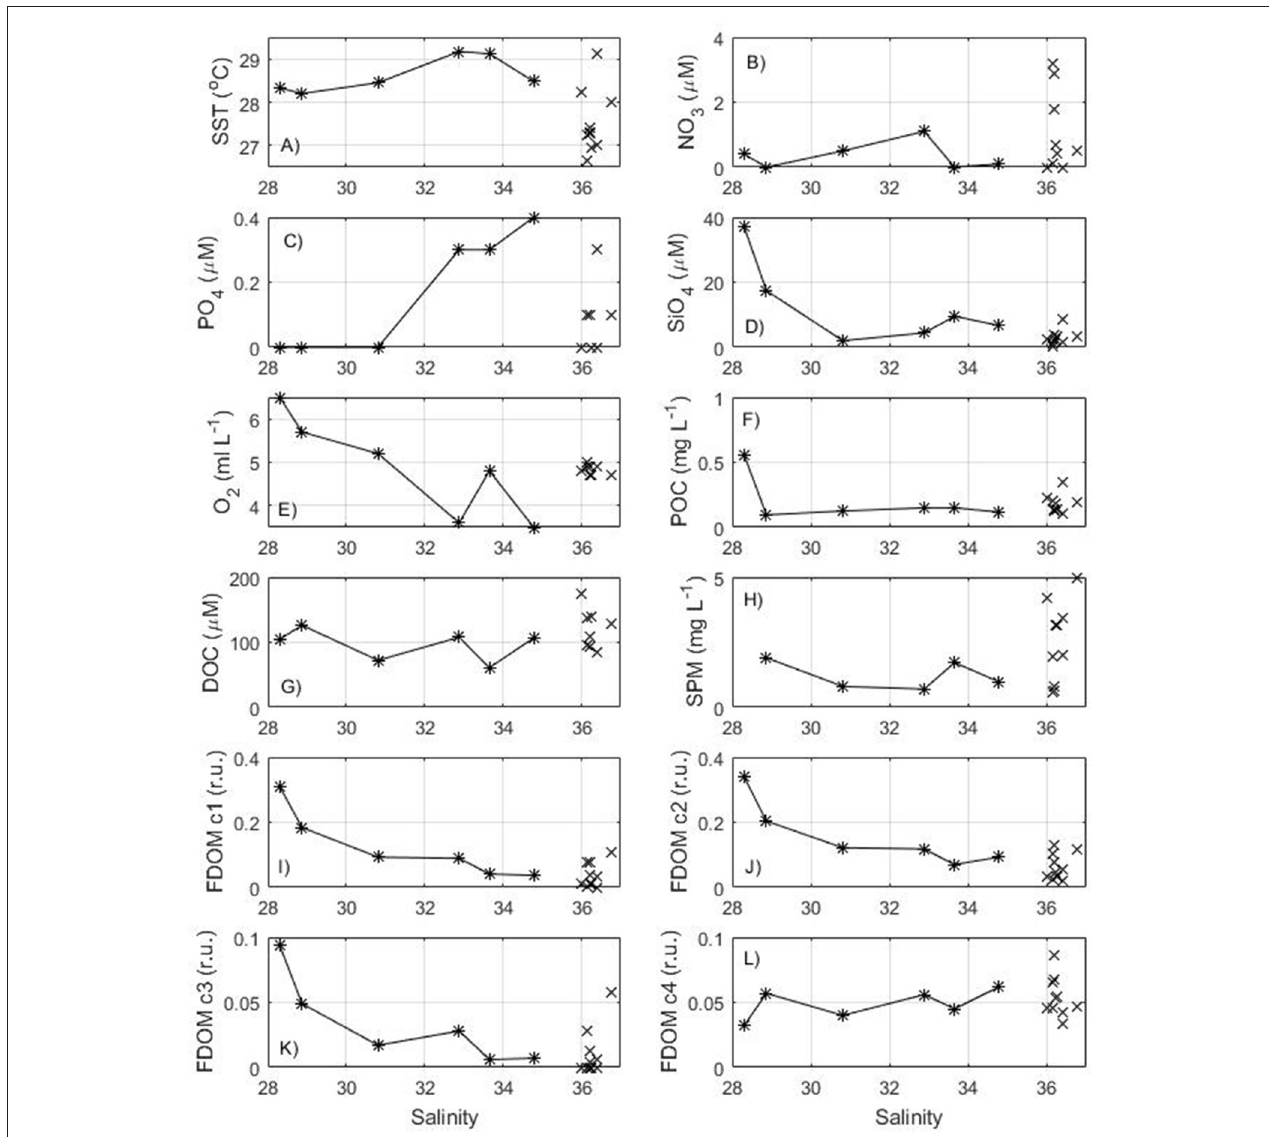
FIGURE 4 | Distribution of surface (A) temperature, (B) nitrate, (C) phosphate, (D) silicate, (E) dissolved oxygen, (F) POC, (G) DOC, (H) Suspended Particulate Matter, (I) C1 component of FDOM, (J) C2 component of FDOM, (K) C3 component of FDOM, (L) C4 component of FDOM as a function of salinity for the Camadas Finas 5 cruise in September 2014. Oceanic stations (1–10) are indicated with a cross and stations of the Amazon plume (11–16) with a